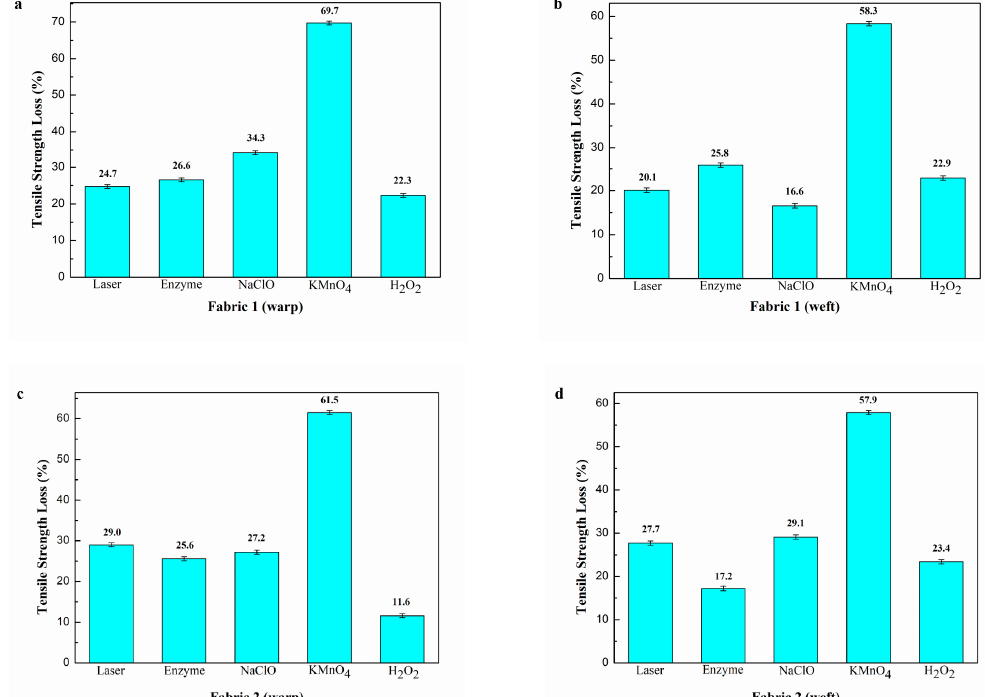
Figure 3. E ff ects of bleaching types on tensile strength loss: ( a) Fabric 1 (warp), ( b ) Fabric 1 (weft), ( c ) Fabric 2 (warp), ( d ) Fabric 2 (weft).